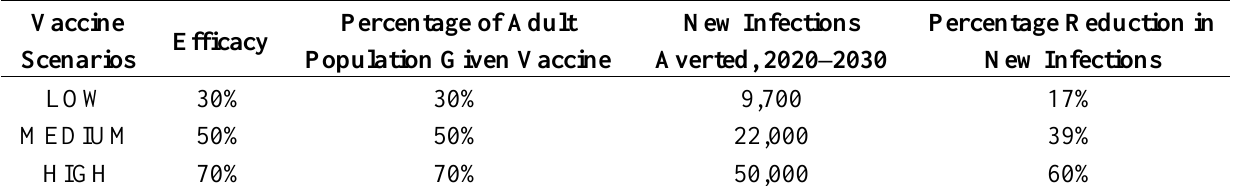
Table 3. Impact of an HIV vaccine in Sichuan province under three